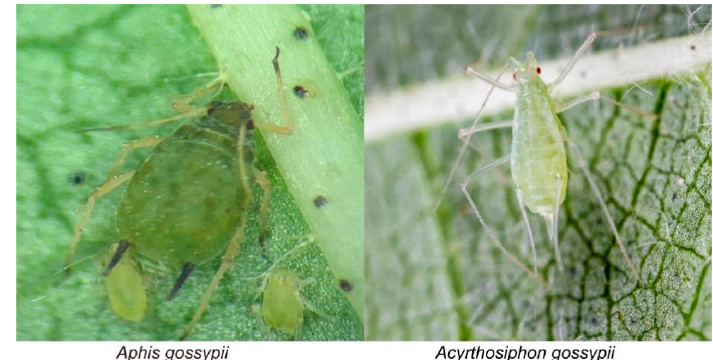
Figure 1. Adult of Aphis gossypii and Acyrthosiphon